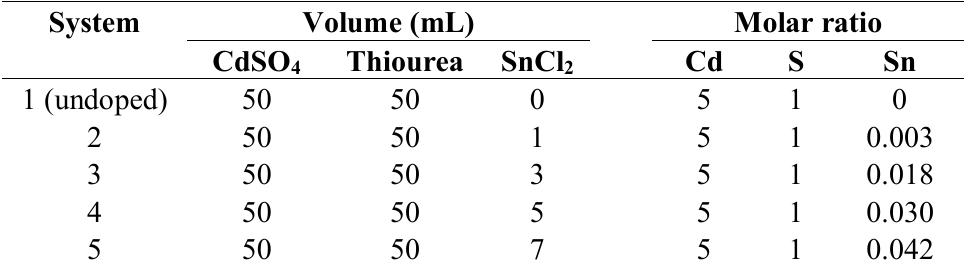
Table 2. Details of chemical solutions used in